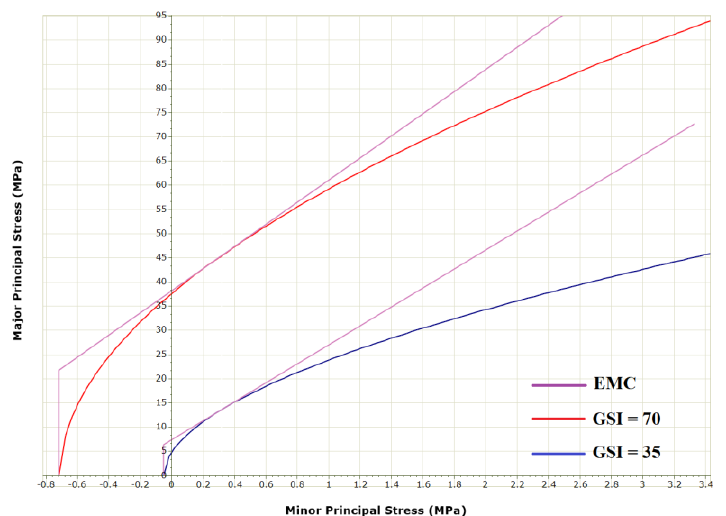
Figure 6. Difference between the generalized Hoek-Brown (GHB) and equivalent Mohr-Coulomb (EMC) criteria for a geological strength index (GSI) of 35 and 70.